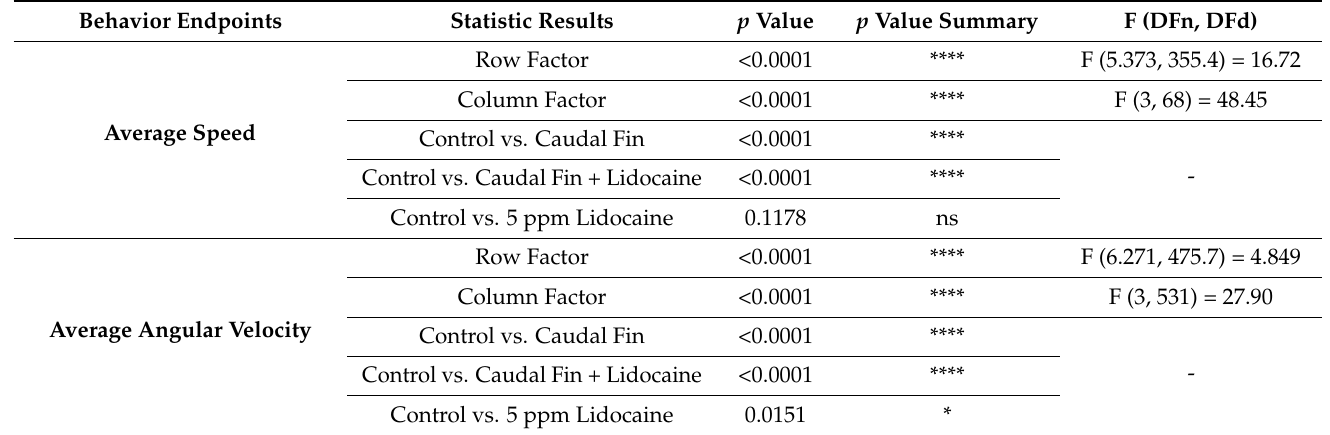
Table A3. Summary of statistic results of each fish behavioral endpoint in the 3D locomotion test from Figure 6. The data were analyzed by mixed models two-way ANOVA continued with Sidak’s multiple comparisons test (rows = time, column = fish group; ns = not statistically